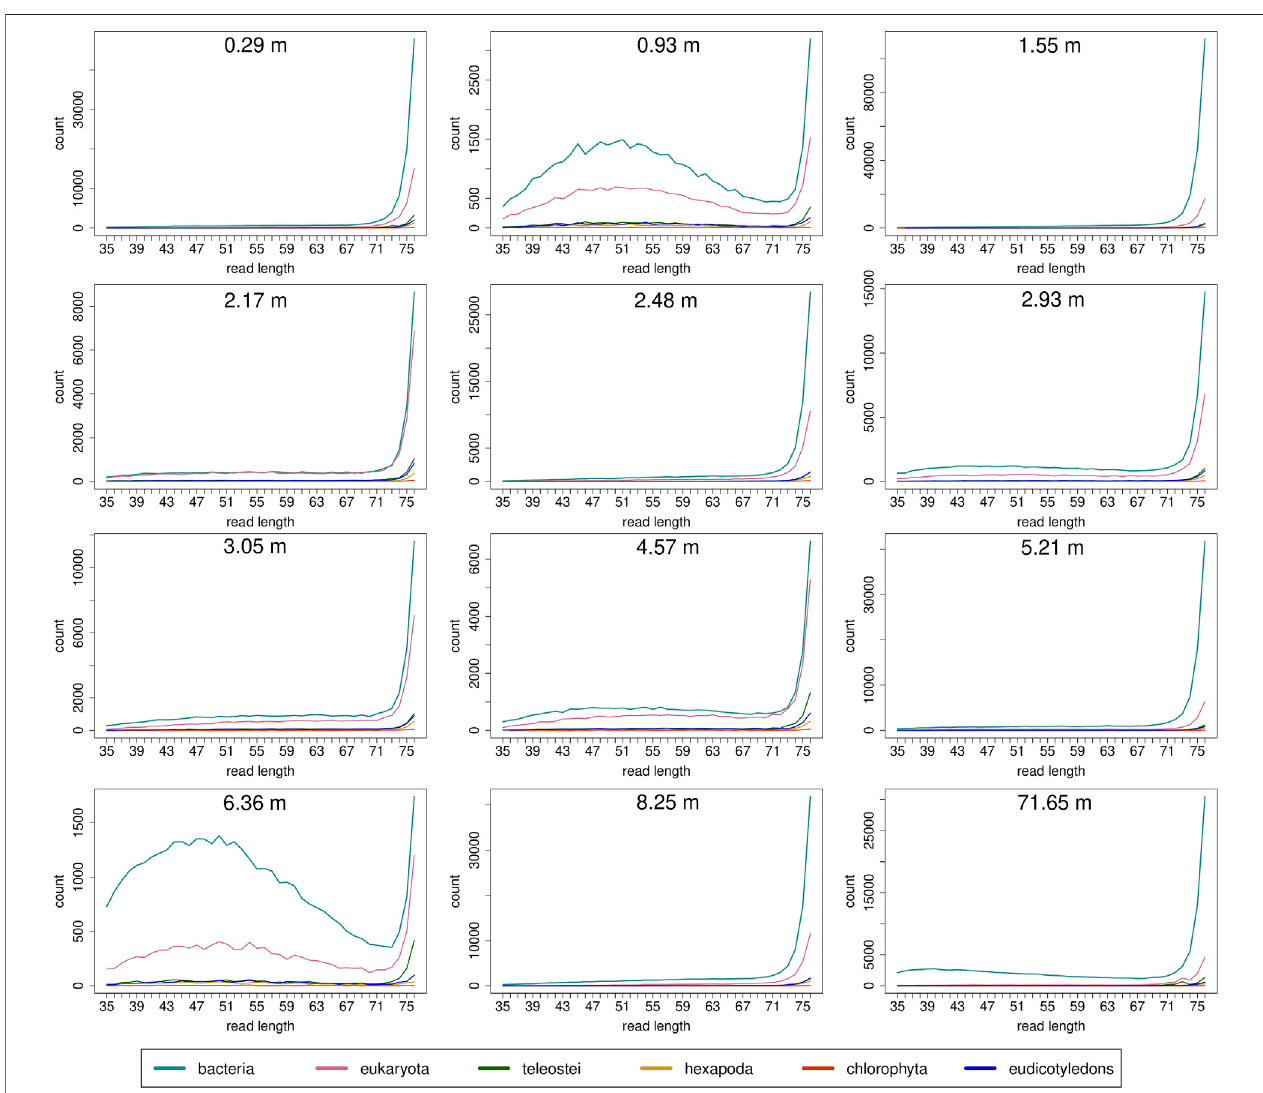
FIGURE3| Read length distribution ofreads assigned toselected taxonomicgroupsafter Kraken2 analysisfor fi rstround capture data. Readgroups were fi ltered by GenBank TaxIDs using KrakenTools (https://github.com/jenniferlu717/KrakenTools, July 2021). Read length distributions mainly follow the trends of the distribution beforeenteringKraken2analysisafterduplicateremoval.Notethatreadcountscanbesubstantiallysmallerasin Figure2 becauseonlyreadsthatcouldbeassignedare displayed.